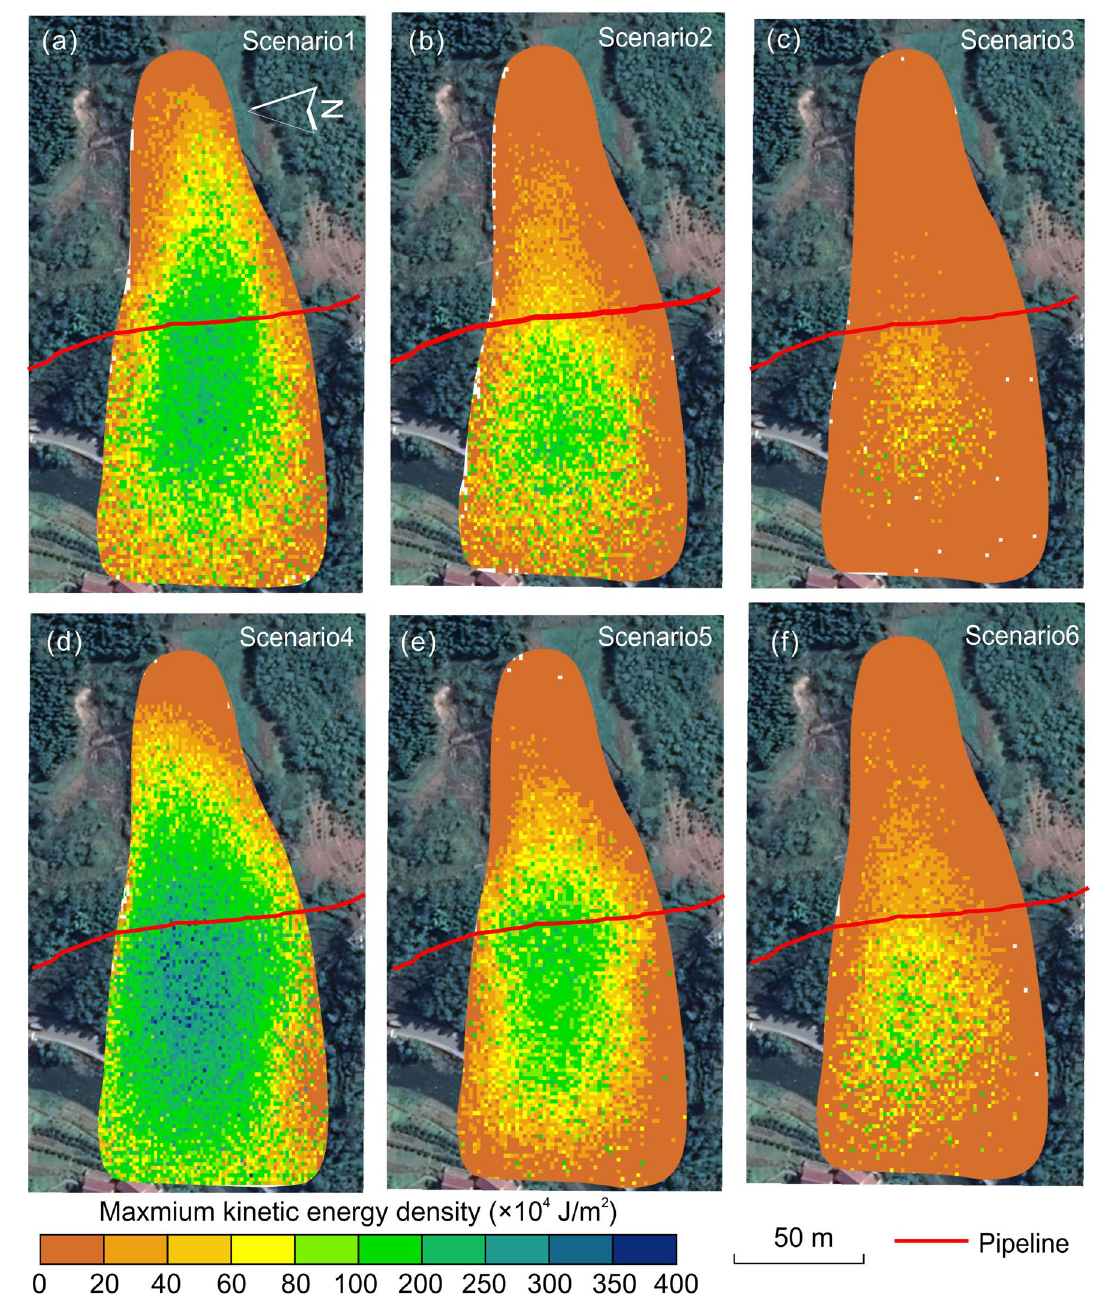
Fig. 7 Landslide maximum kinetic energy density under different simulation